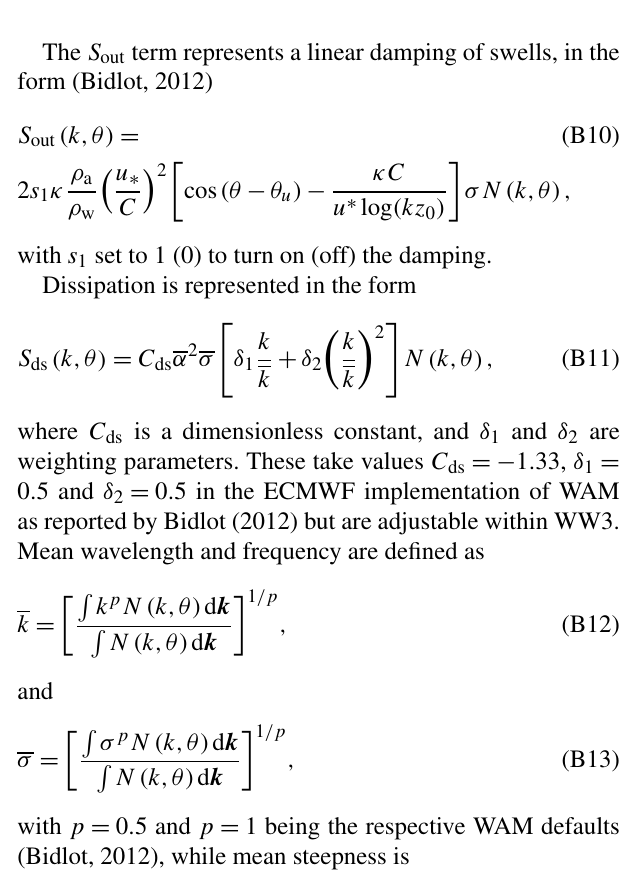
Figure A1. Dependency graph for the Cyclops optimisation suite, configured to use dependencies to allow for concurrent simulations. This example shows four successive cycles, for the case in which up to three parallel simulations are allowed. Arrows represent dependency, which in some cases are combined by a logical OR (enclosed “ + ” symbol). All tasks and explicit dependencies (other than suicide triggers) are shown for cycle N , but dependencies on cycles before N − 3 are omitted for